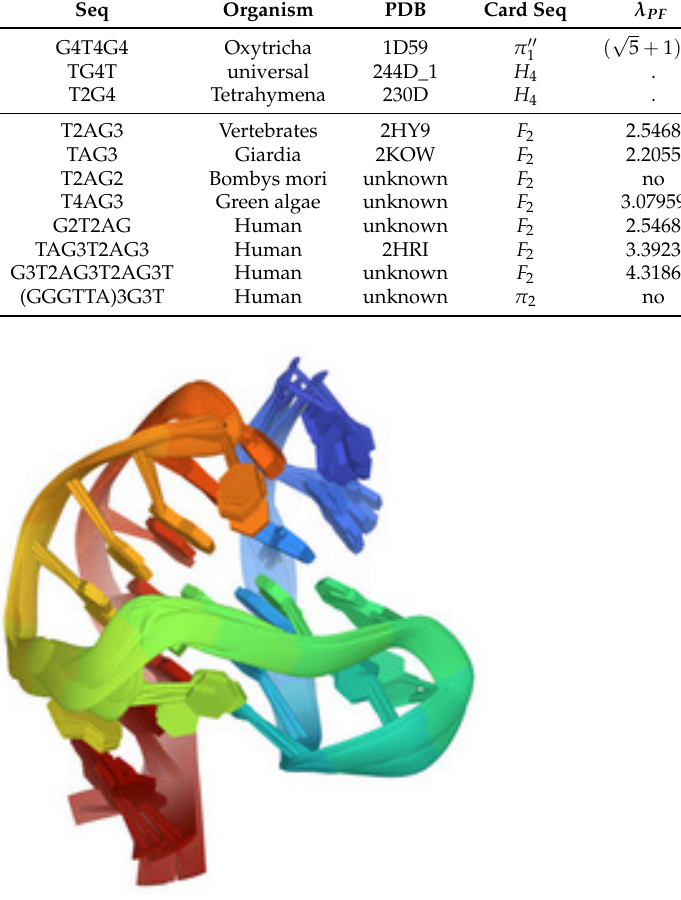
Figure 4. Human telomere DNA quadruplex structure in K+ solution hybrid-1 form, PDB 2HY9